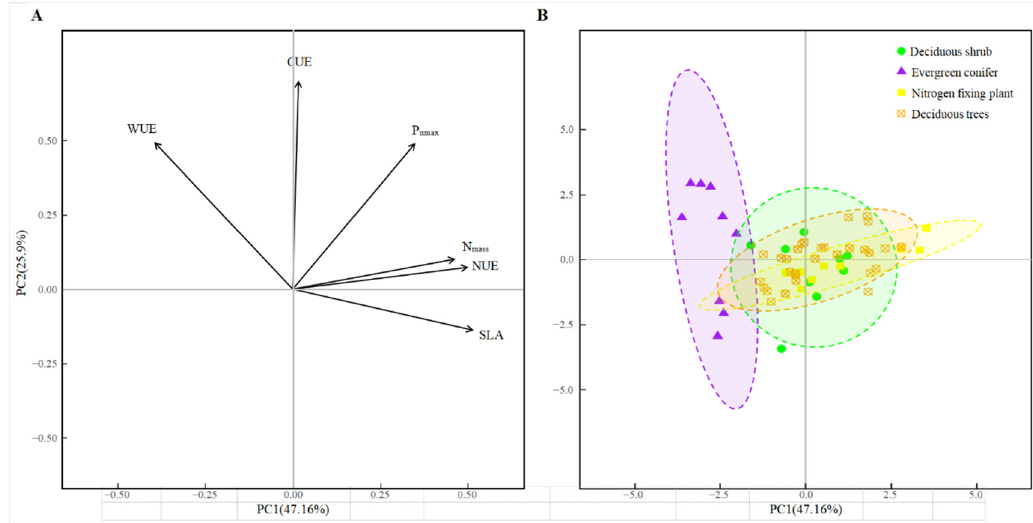
Figure 7. Results of principle component (PC) analyses of leaf traits and resource utilization efficiencies. ( A ) Main trait loads. ( B ) Response of traits to different life forms.